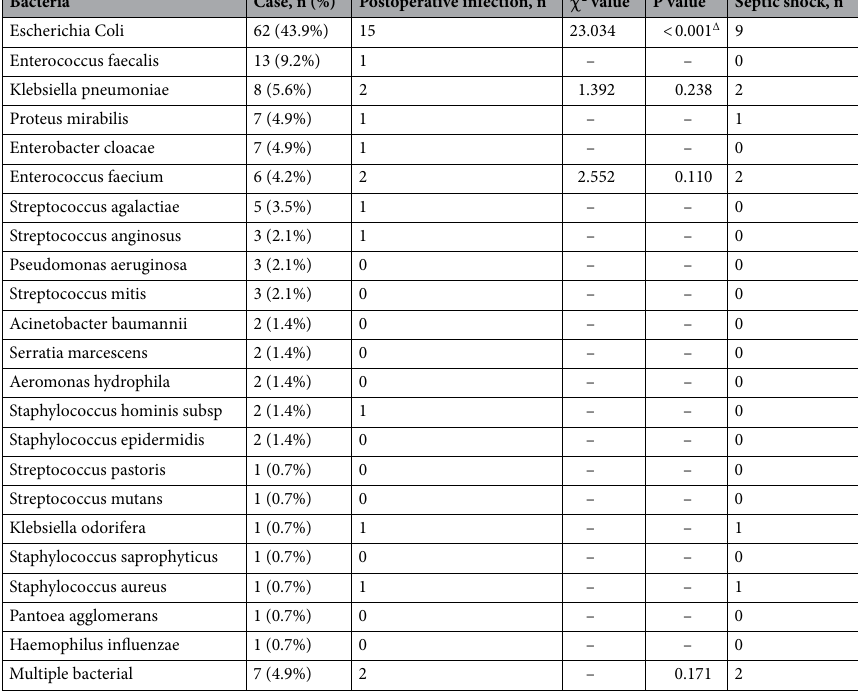
Table 4. Species of urine cultured bacteria and related statistical analysis results. Δ The result was obtained using Fisher’s exact probability test.